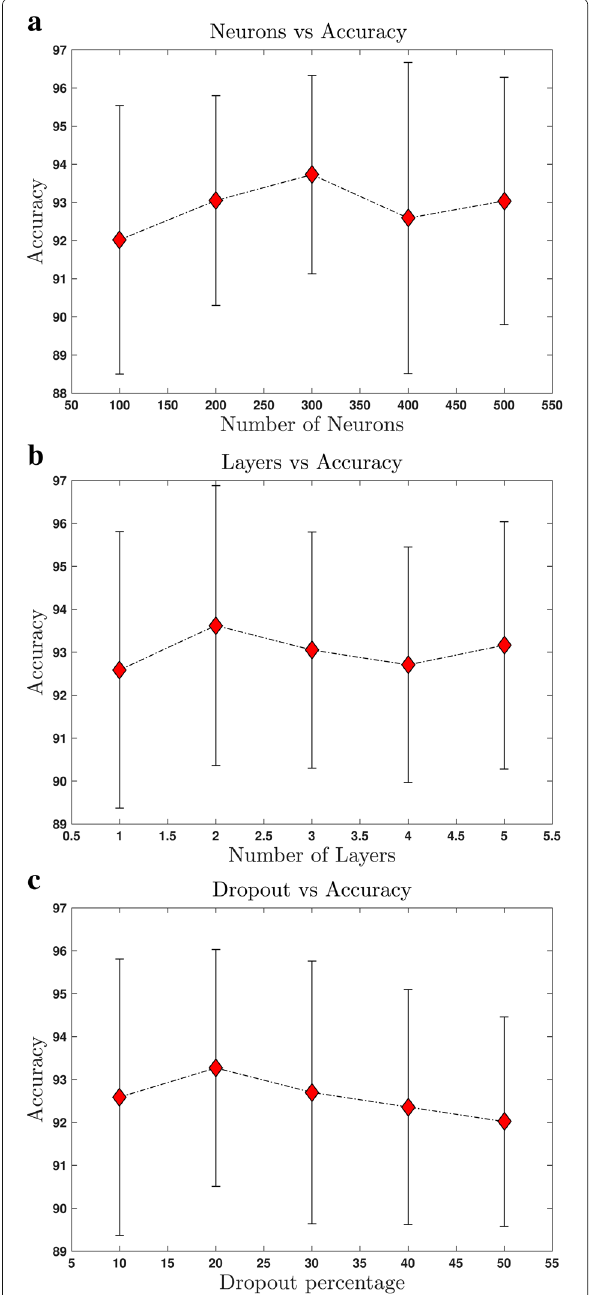
Fig. 22 Effect of parameters on KPD2 + GKPD2 KPF. a Number of neurons in the first hidden layer versus the accuracy of the model. The standard deviation is shown as verticallines . b Number of layers vs the accuracy. c Dropout with accuracy